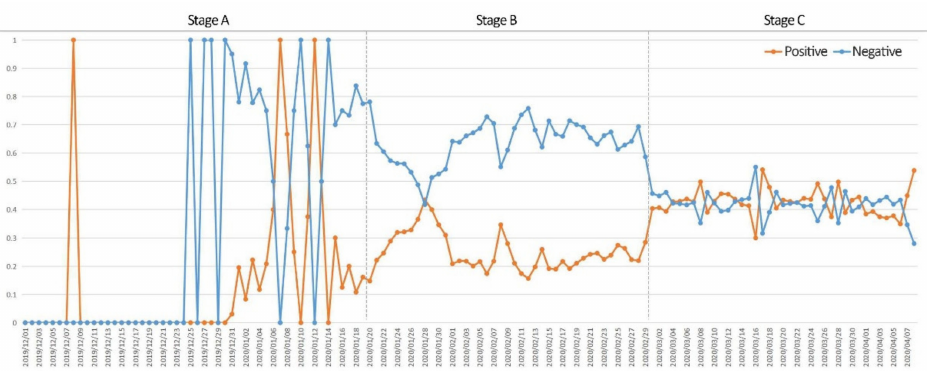
Figure 6. Positive and negative sentiment